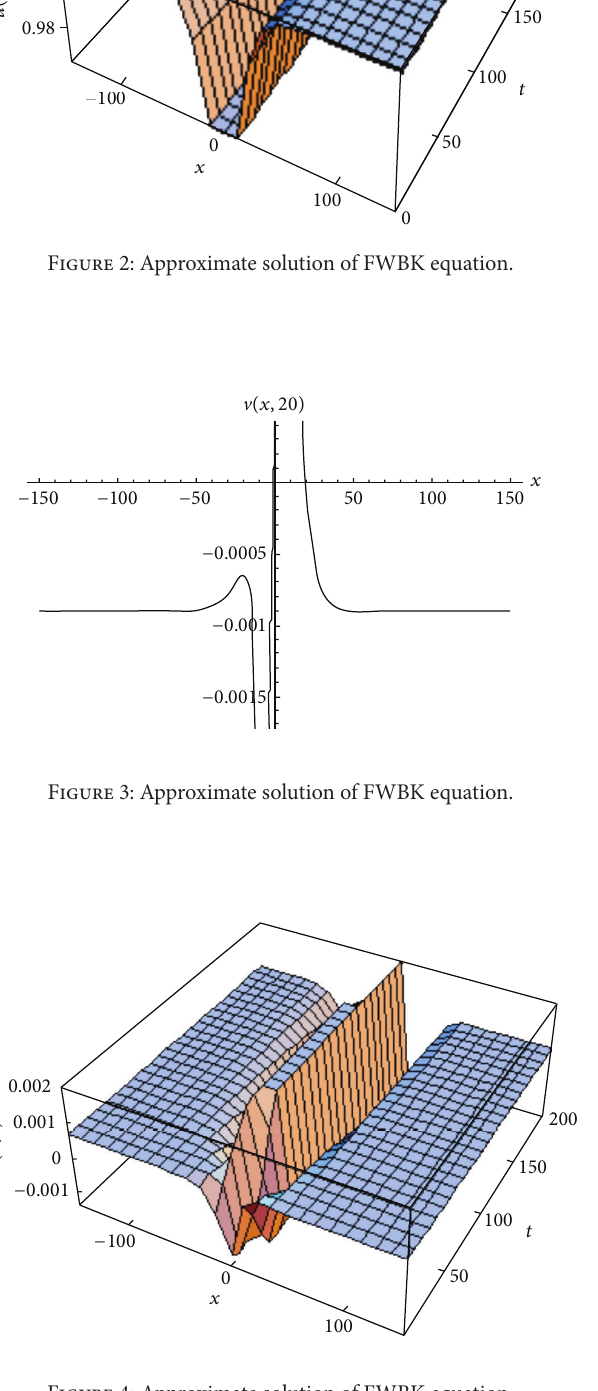
Figure 4: Approximate solution of FWBK